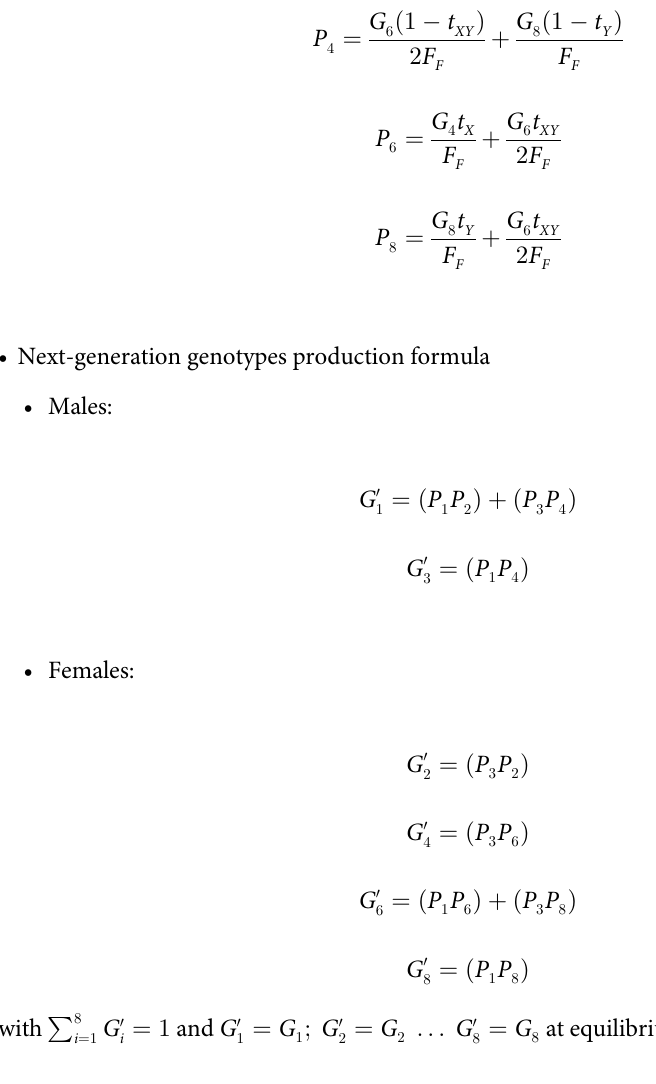
S1 Fig. Box plots of SNP density (a) and repeat proportion (b) in the 78 computationally inferred, putative Y-linked contigs, a subset of 25 of the 78 contigs that were independently validated as Y-linked by PCR, and all the other contigs of the assembly. Thick lines and boxes depict median and interquartile range, respectively. Whiskers are bounded to the most extreme data point within the 1.5 interquartile range. Open circles represent outliers. The underlying data for this figure can be found in S6 Table. SNP, single nucleotide polymor-